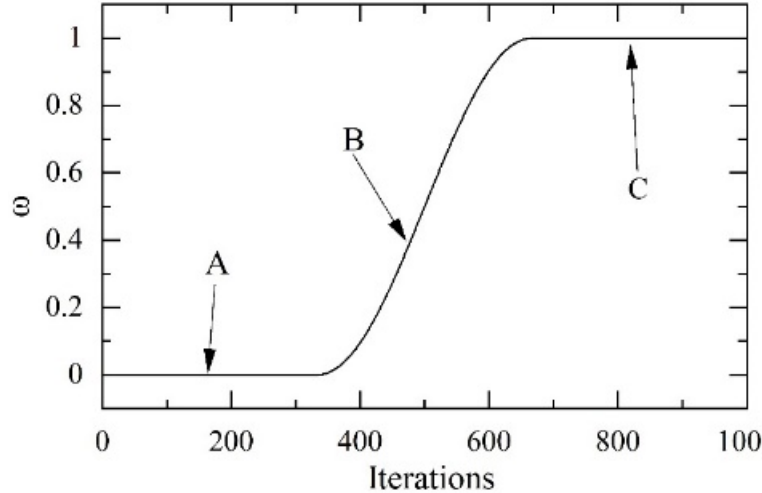
Figure 1. ω modulation factor curve. A: Unreferenced stage; B: progressive reference stage; C: full reference stage.